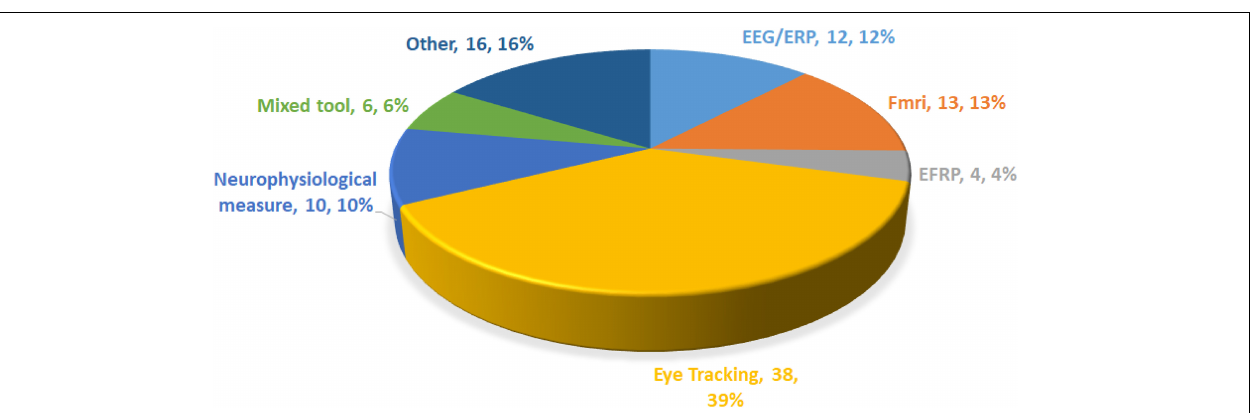
FIGURE 4 | Co-citation Network (Citations ≥ 8).